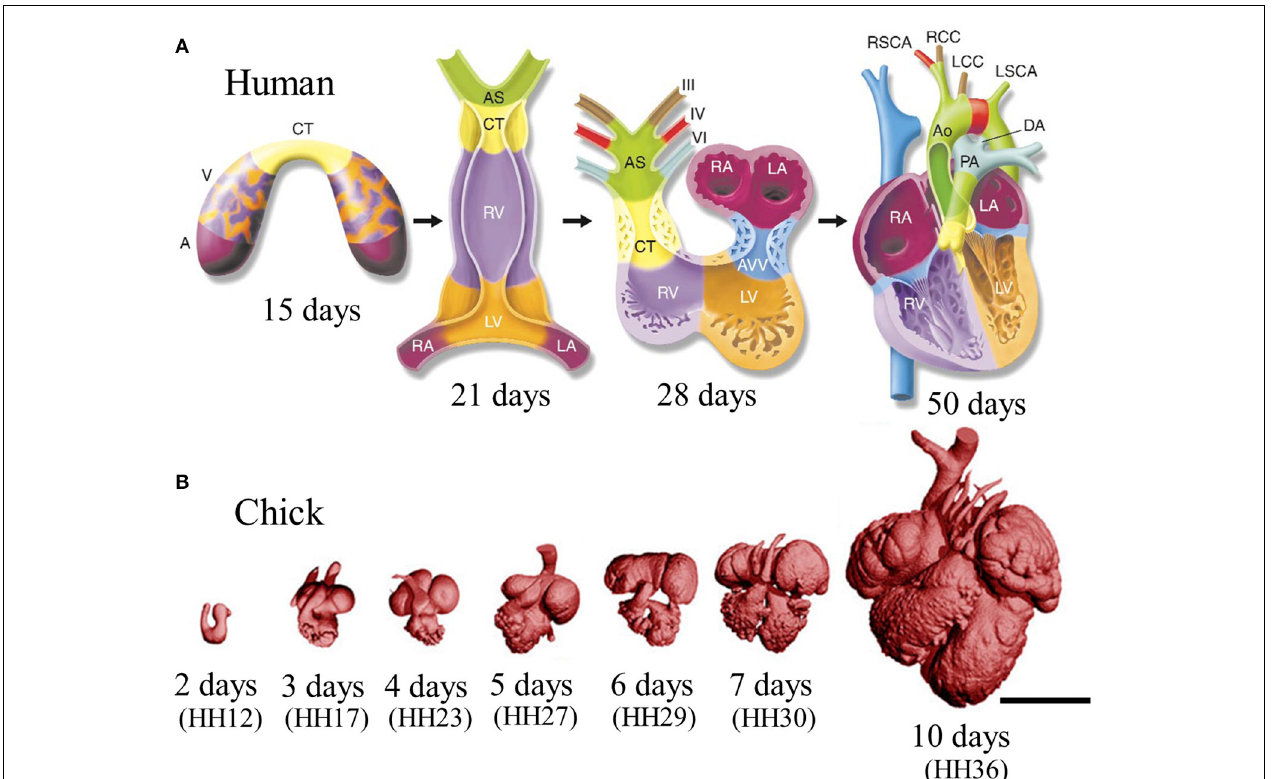
FIGURE 2 | Stages of heart development. (A) Schematic of cardiac morphogenesis in human. Illustrations depict cardiac development with color coding of morphologically related regions, seen from a ventral view. Cardiogenic precursors form a crescent (far-left panel) that is specified to form specific segments of the linear heart tube, which is patterned along the anteroposterior axis to form the various regions and chambers of the looped and mature heart. Each cardiac chamber balloons out from the outer curvature of the looped heart tube in a segmental manner. Neural crest cells populate the bilaterally symmetric aortic arch arteries (III, IV, and VI) and aortic sac (AS) that together contribute to specific segments of the mature aortic